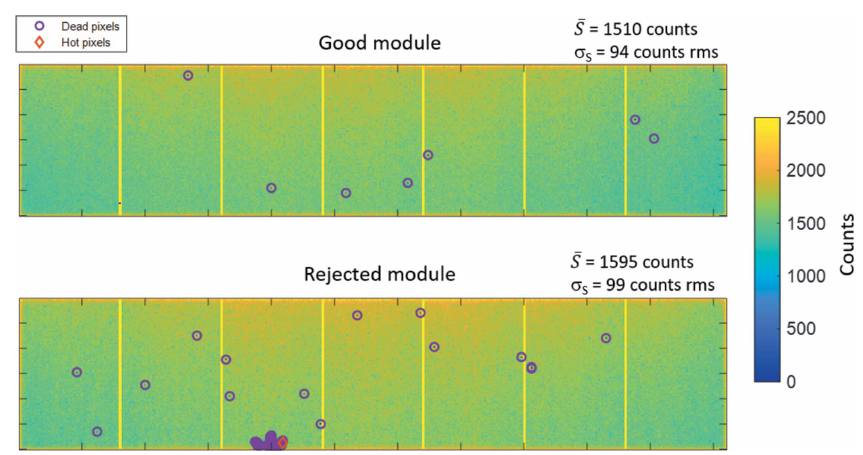
Figure 7 An example of good (upper image) and rejected (lower image) modules after first qualification tests with 14.1 keV X-ray photon